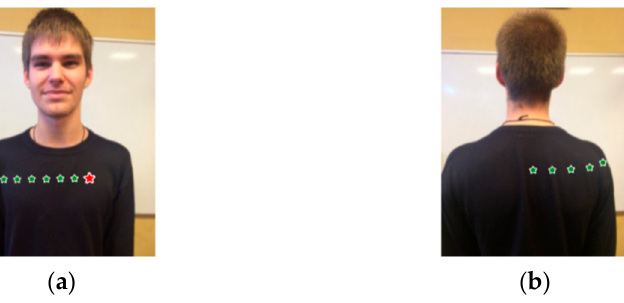
Figure 19. ( a )The antenna position over the human body. ( b )The position of the stationary trans- mitting antenna is shown by the red star; the green stars show the receiving antenna positions.